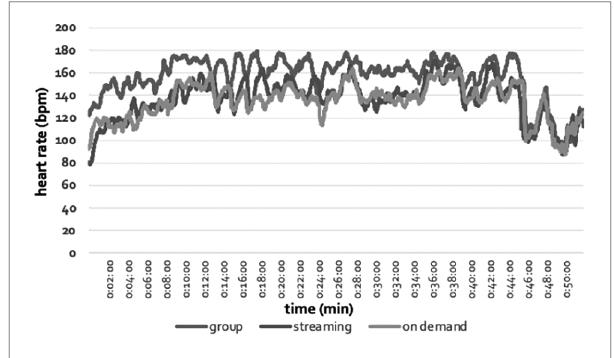
FIGURE 1 Example beat-by-beat heart rate data for a single participant.